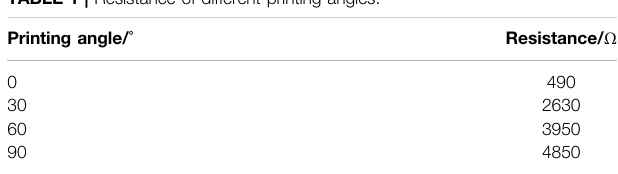
TABLE 1 | Resistance of different printing angles.